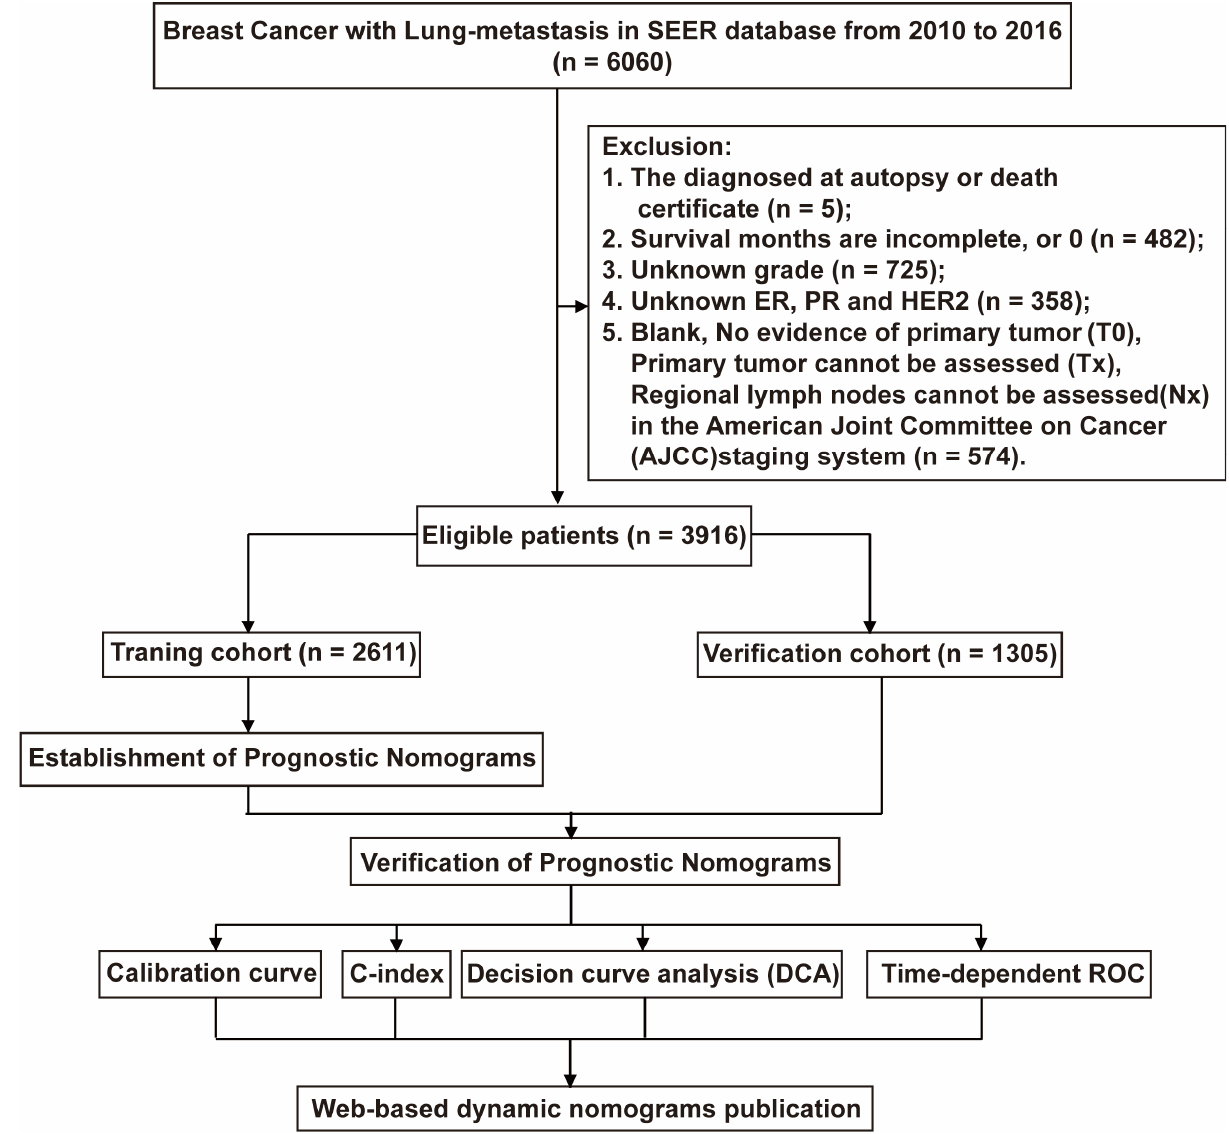
Figure 1. The flowchart of patients was identified in the study. A total of 6060 BCML patients were included from the SEER database, and we excluded 2144 patients based on exclusion criteria. The 3916 patients who met the requirements were randomly divided into training and validation cohort by 2:1. The training cohort was used to construct Norman diagrams, and the validation cohort was used to evaluate the effect of the building model. We validated our constructed Norman plots using the Calibration curve, the C-index decision curve analysis (DAC), and time-dependent ROC meth- ods.